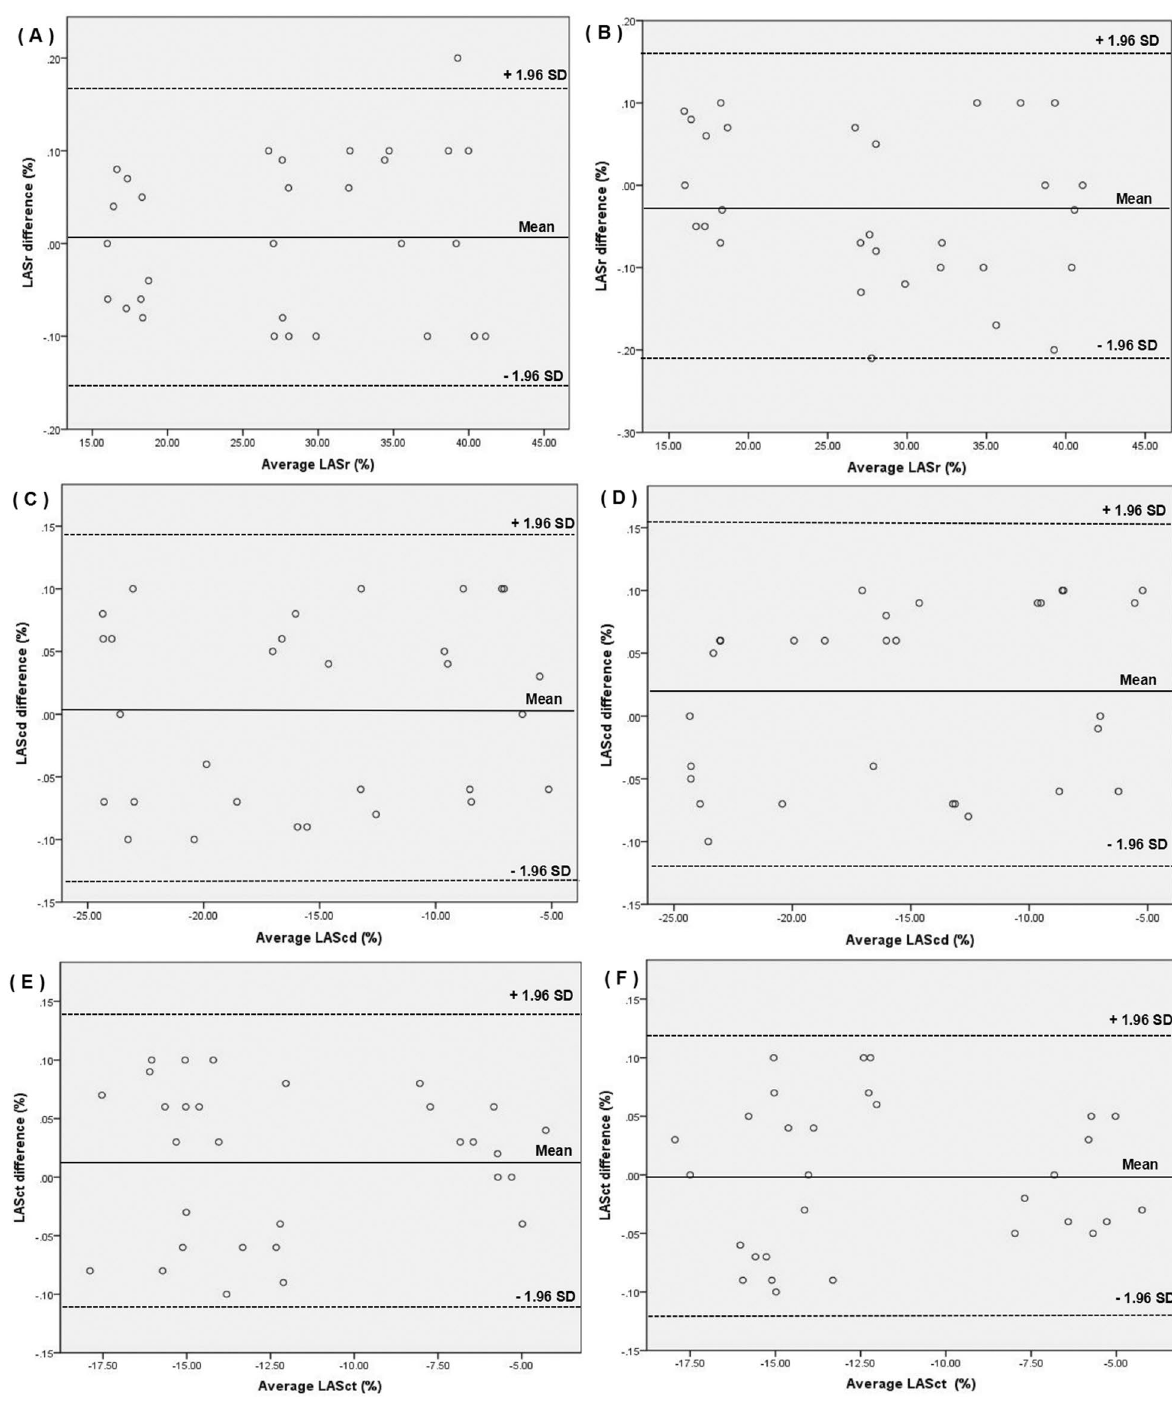
Figure 5. Bland–Altman analyses. Bland–Altman analysis of LASr obtained by 2D-STI showed that there was a high consistency in interobservers ( A ). Bland–Altman analysis of LASr obtained by 2D-STI showed that there was a high consistency in intraobserver ( B ). Bland–Altman analysis of LAScd obtained by 2D-STI showed that there was a high consistency in interobservers ( C ). Bland–Altman analysis of LAScd obtained by 2D-STI showed that there was a high consistency in intraobserver ( D ). Bland–Altman analysis of LASct obtained by 2D-STI showed that there was a high consistency in interobservers ( E ). Bland–Altman analysis of LASct obtained by 2D-STI showed that there was a high consistency in intraobserver ( F